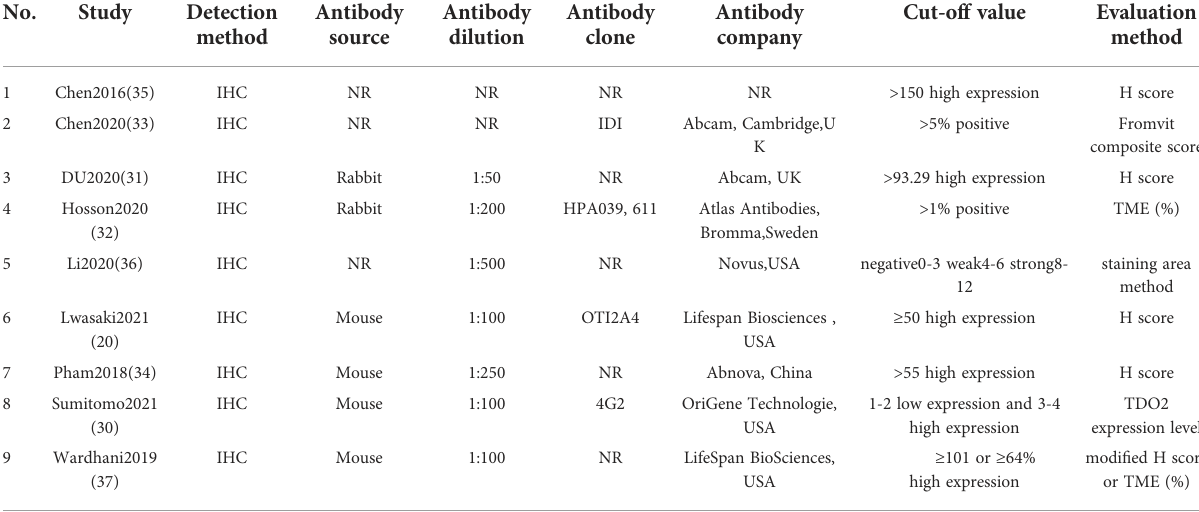
TABLE 2 Summary of immunohistochemical methods for TDO2 detection in the studies included in this meta-analysis.